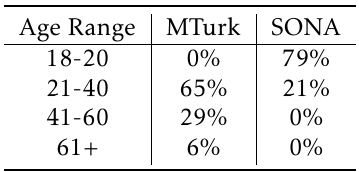
Table 2. Percentage of participants of each age range in MTurk and SONA.